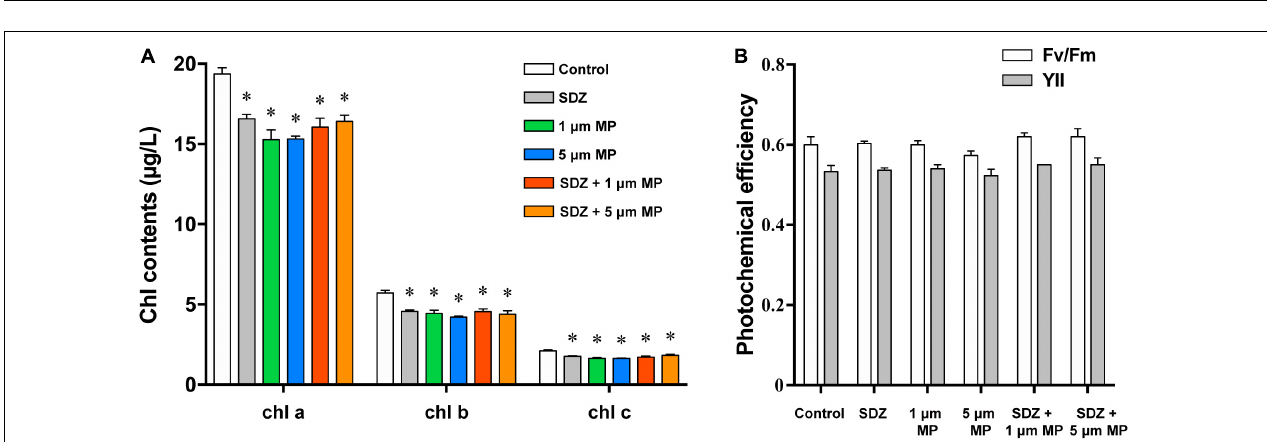
FIGURE 4 | The superoxide dismutase (SOD) (A) and glutathione peroxidase (GSH-Px) (B) enzyme activities of C. reinhardtii exposed to PS-MPs (1 and 5 µ m) and/or SDZ (50 mg l − 1 ). Values are means ± SEM of three replicates and significant differences ( p < 0.05) are denoted with different letters.